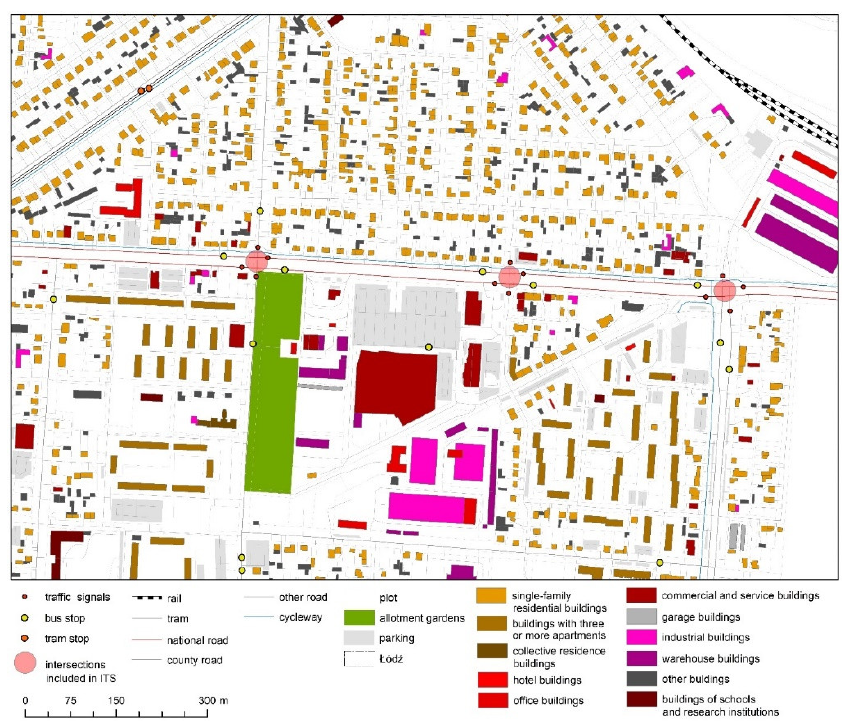
Figure 6. Selected elements of the transport infrastructure and functional differentiation of built-up areas in the vicinity of the researched area. Source: own elaboration based on the Database of Topographic Objects and OpenStreetMap.